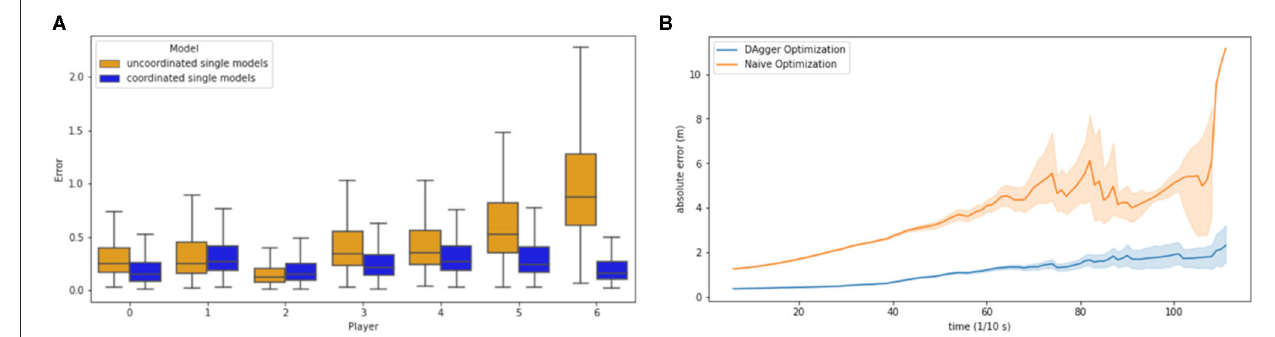
FIGURE 6 | (A) Model error for different roles according to specific models. Blue is the coordinated single model. Yellow is the uncoordinated single model. (B) Average rolled-out error throughout play, until the quarterback throws a pass. The blue line indicates the rolled-out error under DAgger optimization. The orange line indicates the rolled-out error without DAgger optimization.